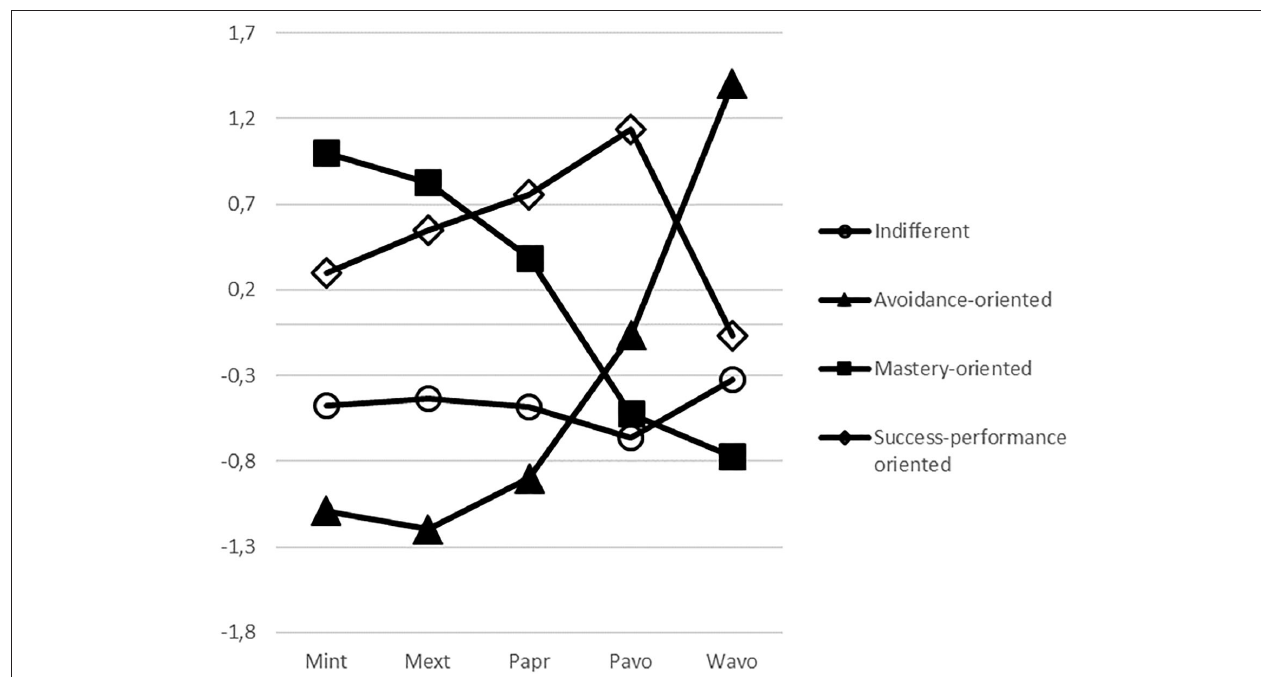
FIGURE 1 | Standardized mean scores on achievement-goal orientation scales as a function of group membership. Mint, mastery-intrinsic orientation; Mext, mastery-extrinsic orientation; Papr, performance-approach orientation; Pavo, performance-avoidance orientation; Wavo, work-avoidance orientation.